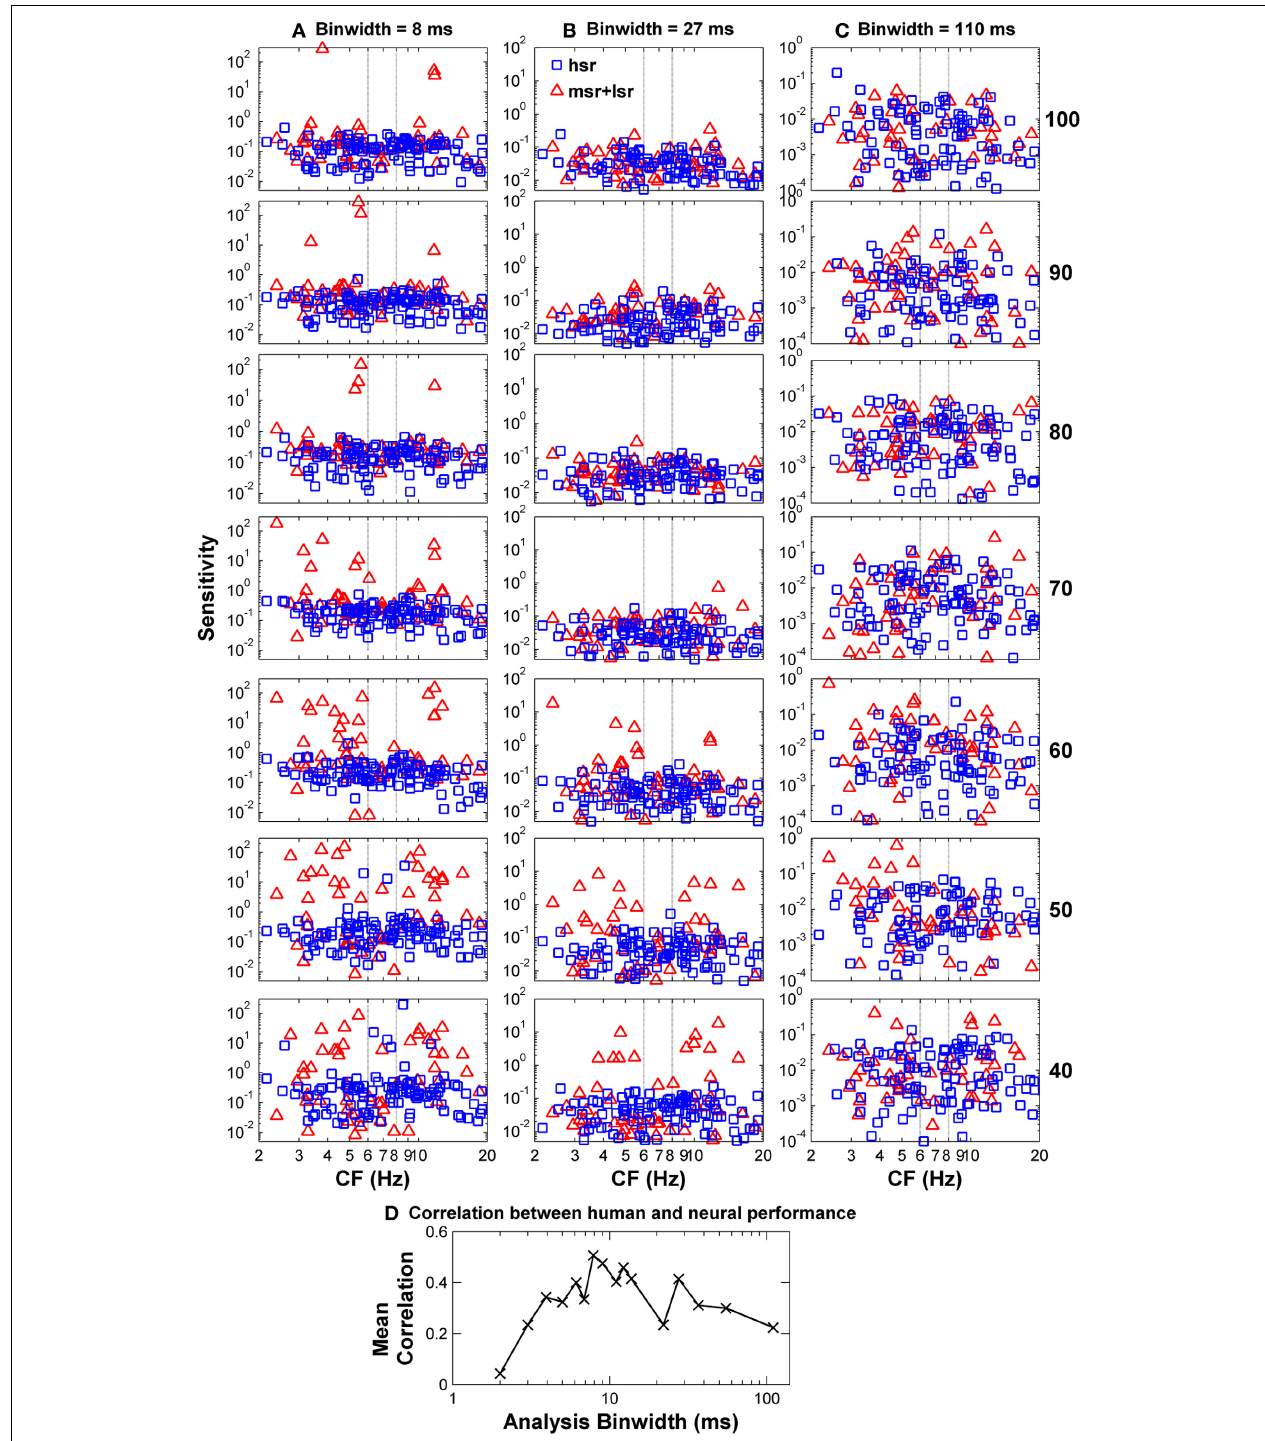
FIGURE 7 | Auditory nerve data: individual AN fiber sensitivity as a function of fiber’s CF. Sensitivity values for HSR and LSR fibers are illustrated by blue squares and red triangles, respectively. Sensitivity was calculated for three different time binwidths: 8ms (A) , 27ms (B) , and 110ms (C) . Notice the different sensitivity scales used for the different binwidths. Stimulus level increases from the bottom to the top panel as indicated by the numbers on the right side of the figure (in units of dB SPL). Individual